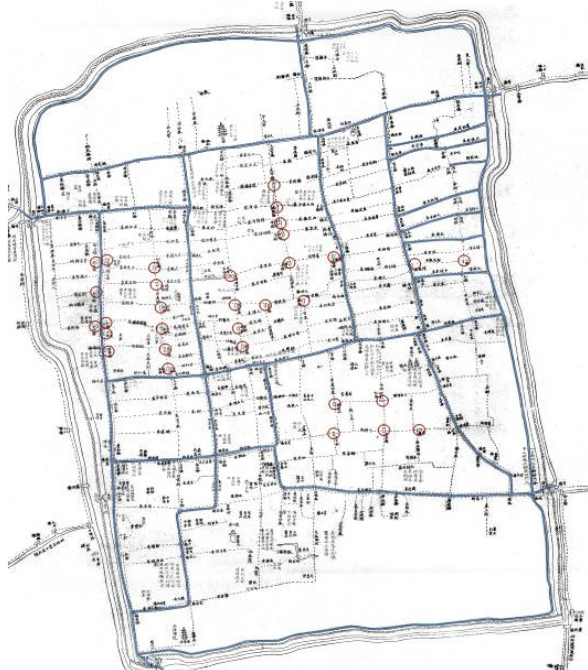
Figure 16. The map of 1864-1873 (map code 6), the red circles are marked bridges without